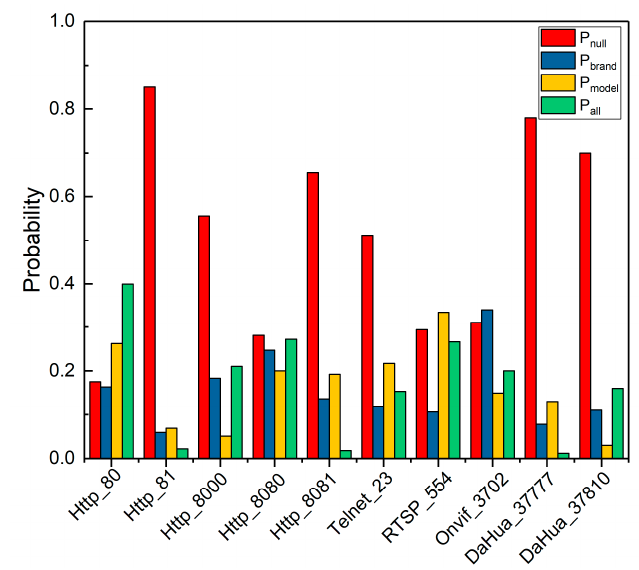
Figure 5. Attributes proportion rate of ten Webcam protocol banners.